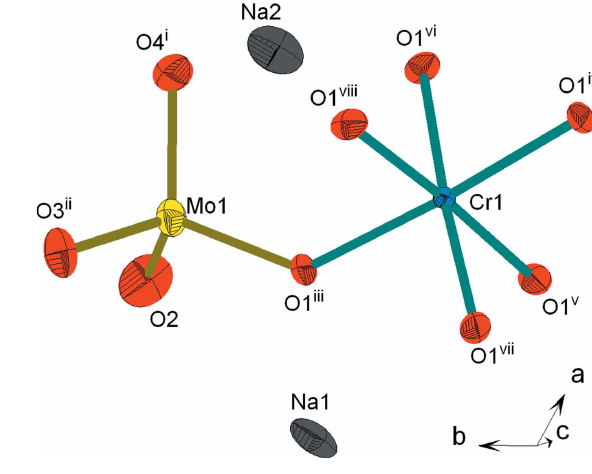
Na 9 Cr(MoO 4 ) 6 . Les e´llipsoı¨des ont e´te´ de´finis avec 50% de probabilite´. [Codes de syme´trie: (i) (cid:2) x + 2